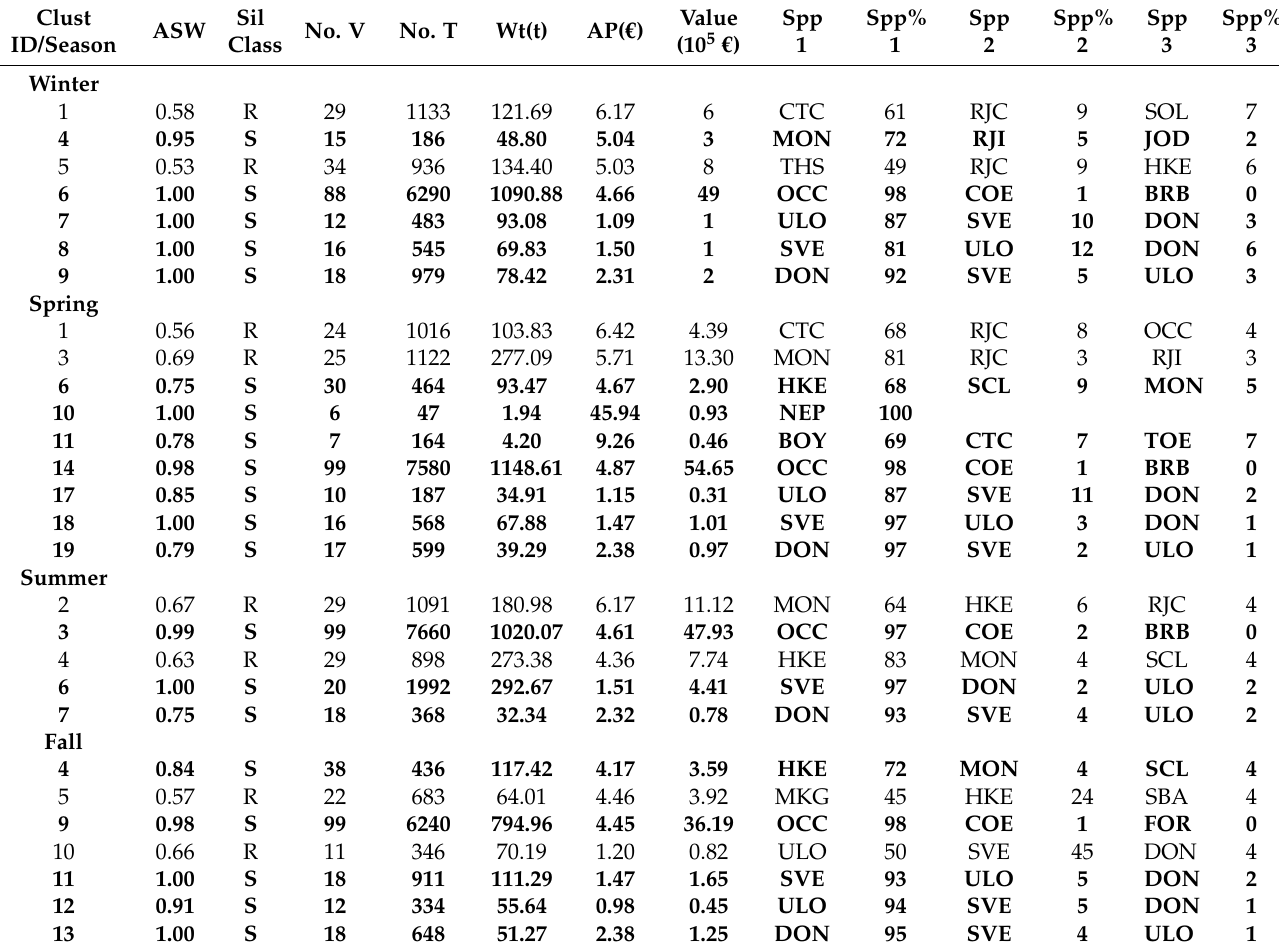
Table 3. Outputs for seasonal clusters (Annex Figure S3) with the cluster ID, average silhouette width of the cluster (ASW), the silhouette class (SC; S = strong, in bold; R = reasonable), number of vessels (No. V), number of trips (No. T), total weight (in tonnes), average price (AP) in Euros, total value in Euros, the three top species (Spp) and the percentage (Spp%) that each species represented within the species (in quantity). (FAO Codes of primary species for reasonable and strongly structured clusters (Annex Table S3): BOY= Spiny-dye murex; COE= Conger eel; CTC = Cuttlefish; DON = Donax clam; HKE = Hake; MKG = Thickback sole; MON = Monkfish; OCC = Octopus; THS = Bastard sole; SBG = Gilt-head seabream; SVE = Striped venus clam; ULO = Surf